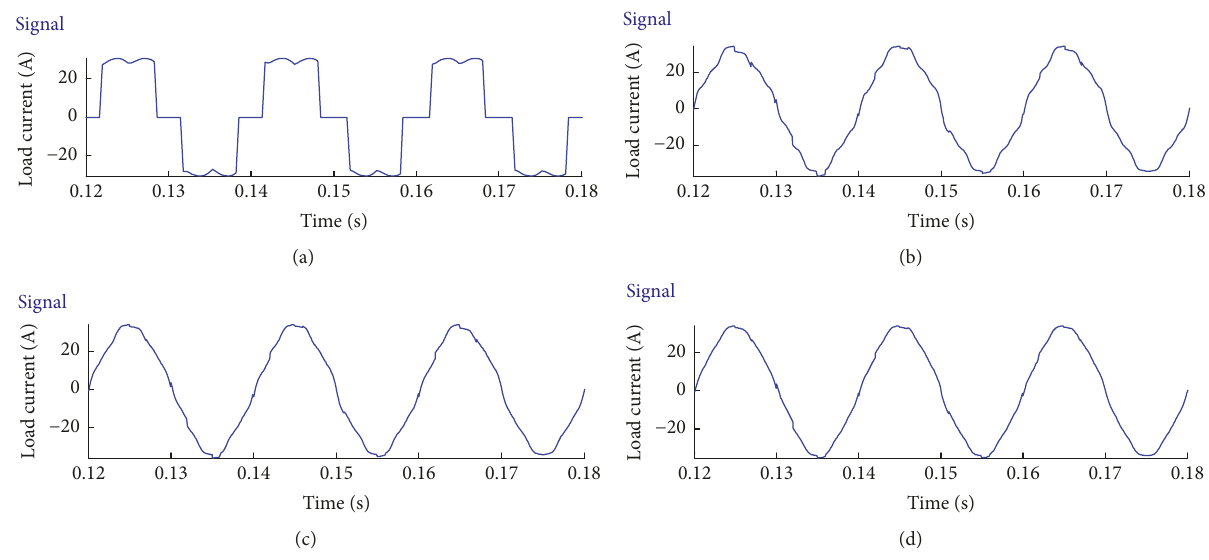
Figure 5: Load current waveform comparison. (a) Load current waveform without decoupling method. (b) Load current waveform with feedforward decoupling method. (c) Load current waveform with inverse system decoupling method. (d) Load current waveform with generalized inverse system decoupling method.